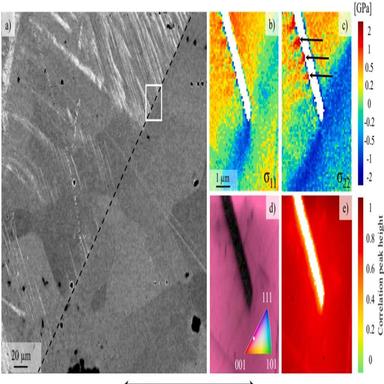
Ribbon-like retained and pinned martensite. (a) SEM micrograph of retained martensite after the second loading cycle up to εmax = 2.2% of the 〈113〉 oriented single crystal loaded in compression. Calculated residual stress σ11 in horizontal (b) and σ22 in vertical direction (c). (d) Crystallographic orientation of the austenitic matrix color coded with respect to the loading direction (horizontal). (e) Peak height of cross-correlation coefficient. (For interpretation of the references to color in this figur